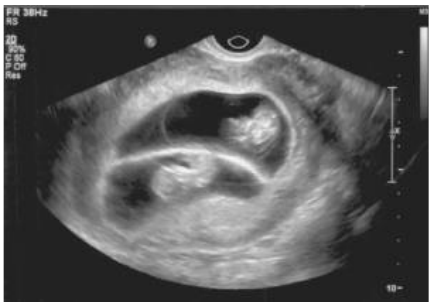
Figure 1: Patient at 10 + 1 weeks EGA with no evidence of abnormally thickened membrane.